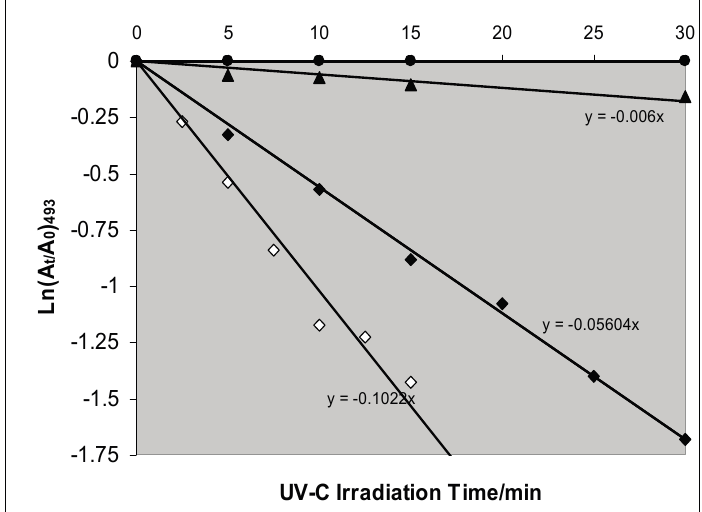
Figure 12. UV-C decolouration of 0.05 mM RO16 in the presence of TiO 2 ( ● UV-C only: